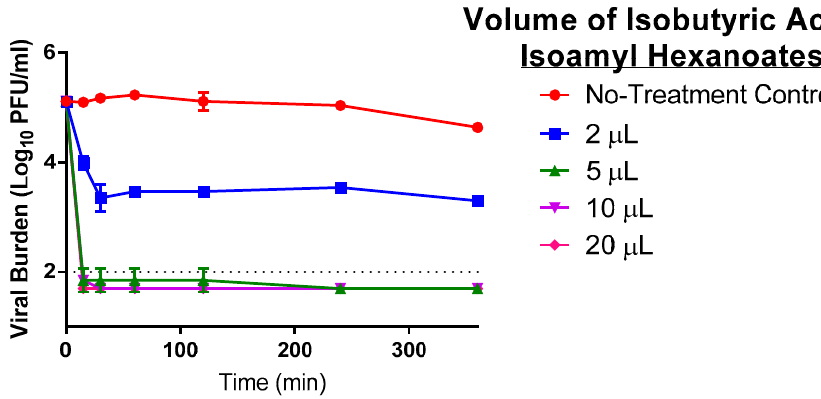
Figure 6. The antiviral effect of various volumes of isobutyric acid in combination with isoamyl hexanoates (esters) (at a ratio of 7:2, acid to esters) to inactivate infectious SARS-CoV-2. A 1 mL suspension of 10 5 PFU of SARS-CoV-2 was directly exposed to various volumes of liquid the Propylamylatin formula and incubated at 37 °C. At various times post-exposure, viral suspensions were harvested, and viral burden was quantified by plaque assay in Vero E6 cells. Viral burden is reported as log 10 PFU/mL. Data points correspond to the geometric mean of two independent samples and error bars represent one standard deviation. The horizontal dashed line signifies the plaque assay limit of detection.